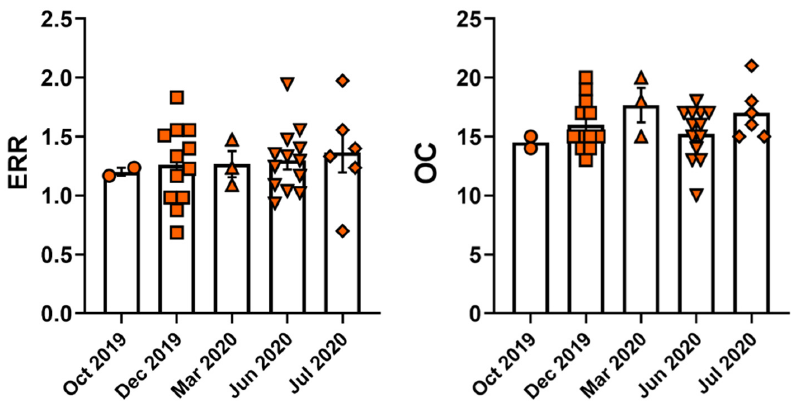
Figure 3. ERR and OC values calculated from participant’s survey during the months of